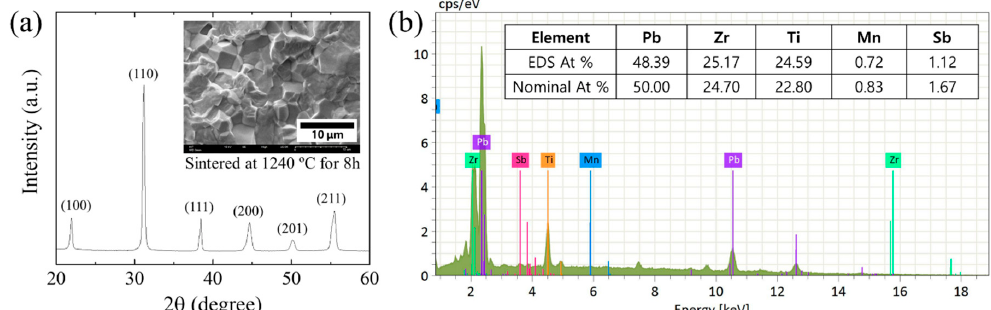
Figure 1. ( a ) XRD pattern of PZT-PMS ceramic sample sintered at 1240 °C for 8 h. Inset image presents an SEM microstructure image of the sintered PZT-PMS sample. ( b ) Energy-dispersive X-ray spectroscopy (EDS) result of the sintered PZT-PMS ceramic sample.